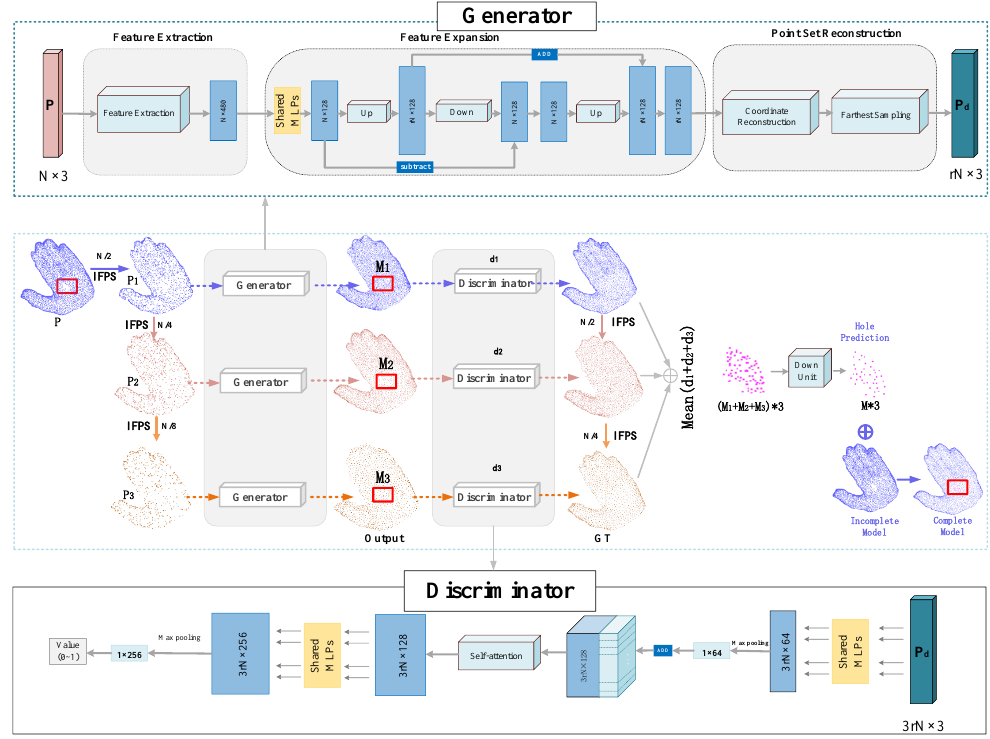
Figure3. Overview of MU-GAN. 1) We first obtain k (k = 3) point cloud data ( 𝑃 1 , 𝑃 2 , 𝑃 3 ) of different points of an artifact model 𝑃 . A generator is used to generate up-sampled 2× clean, dense complete point cloud data for each noisy, sparse point cloud data. The generated multi-scale point cloud data are used as input to train the discriminator. 2) To generate uniform patches, the multi-scale feature- fused point cloud data are generated through the stages of feature extraction and point cloud recon- struction, and the missing regions are extracted as filler patches. 3) The input data to be repaired and the filler patches are merged to obtain the final point cloud repair results.